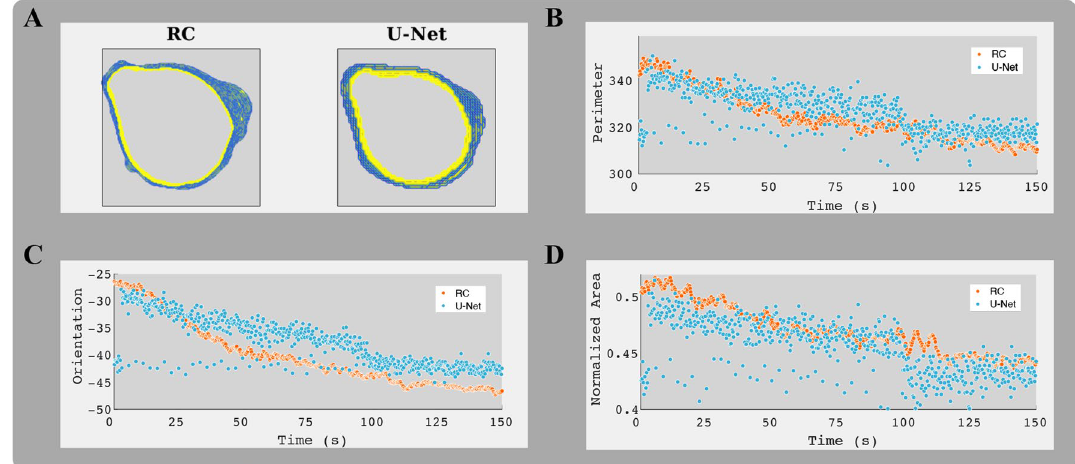
Figure 6. Predicted temporal contours evolution for a representative Jurkat T-cell and segmentation in the Fluo-4 emission data. ( A ) Unlike the discrete contour trajectory returned by the standard U-Net, the contours predicted by the RC method evolve continuously. ( B ) Frame-to-frame changes in contour length (in number of pixels) of the predicted masks. ( C ) Mask orientation, the angle (in degree) between the horizontal image axis (i.e., x-axis) and the major axis of an ellipse with the same second-moments as the segmented object, over time. ( D ) Normalized mask area over time. The area of the object was divided by the total number of pixels in each frame. The same illustration for the results of the U-Net-LSTM is presented in the supplementary materials (Fig. S5) [Graphics created with MATLAB and the Image Processing Toolbox Release 2019b, The MathWorks, Inc. (http:// mathw orks. com/ produ cts/ image. html)].